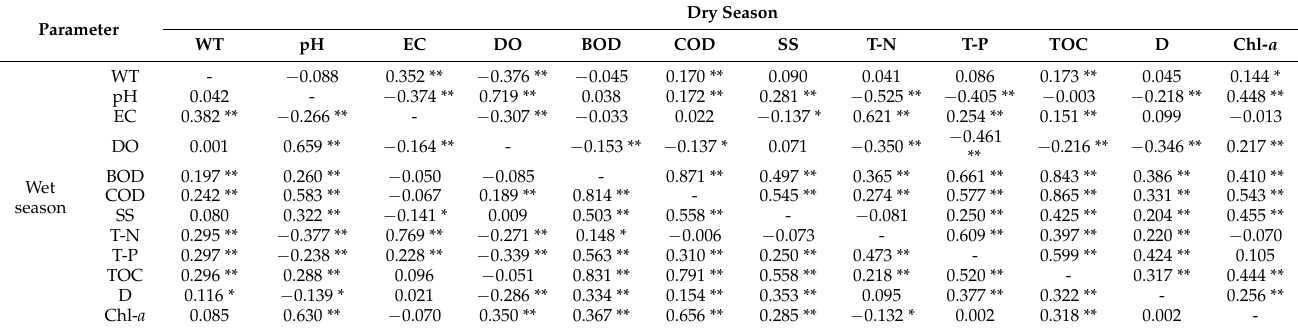
Table 1. Pearson’s correlation coefficients for the different water quality parameters in the dry and wet seasons.